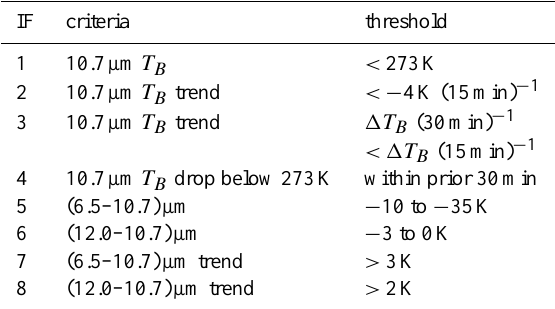
Table 1. SATCAST GOES-11 IFs for the detection of